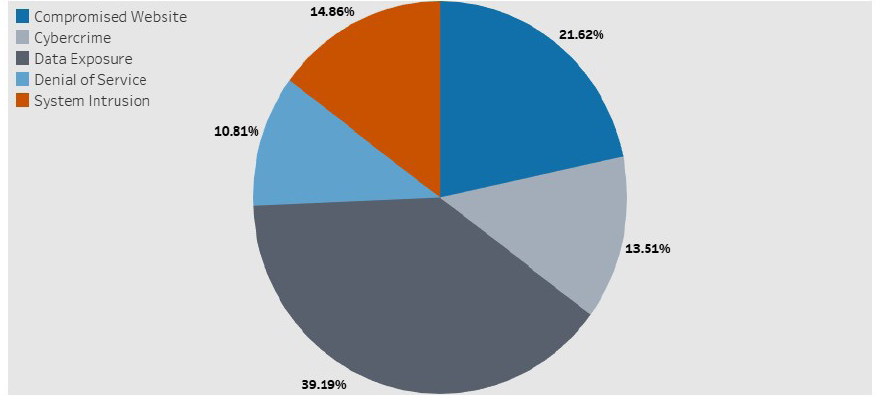
Figure 5: Cyber incidents by type,